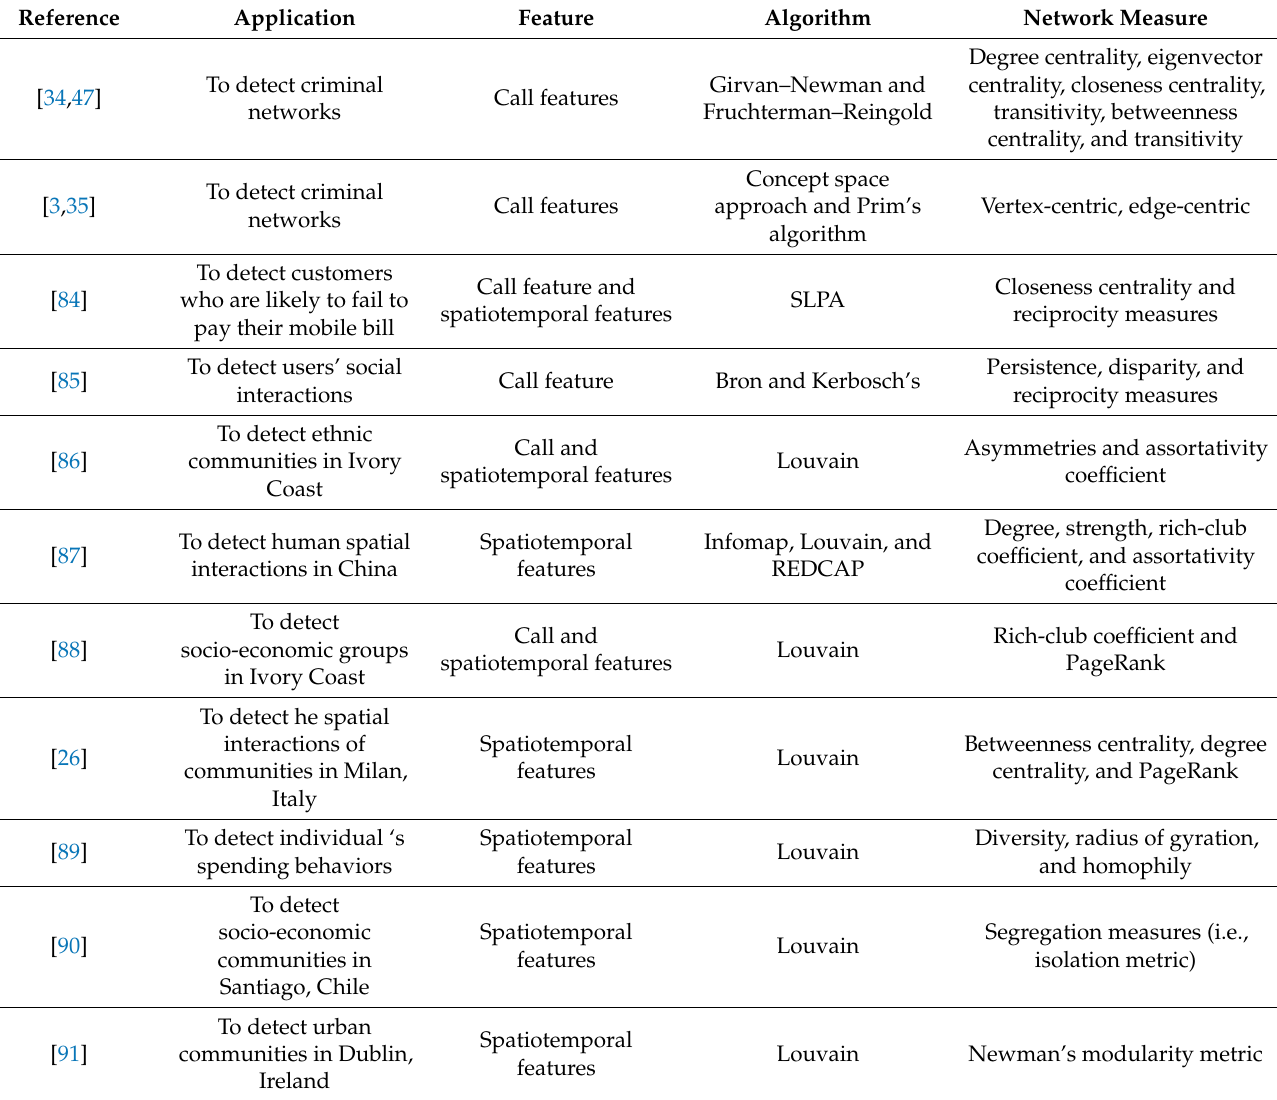
Table 5. Summarizes social network applications, algorithms, and network